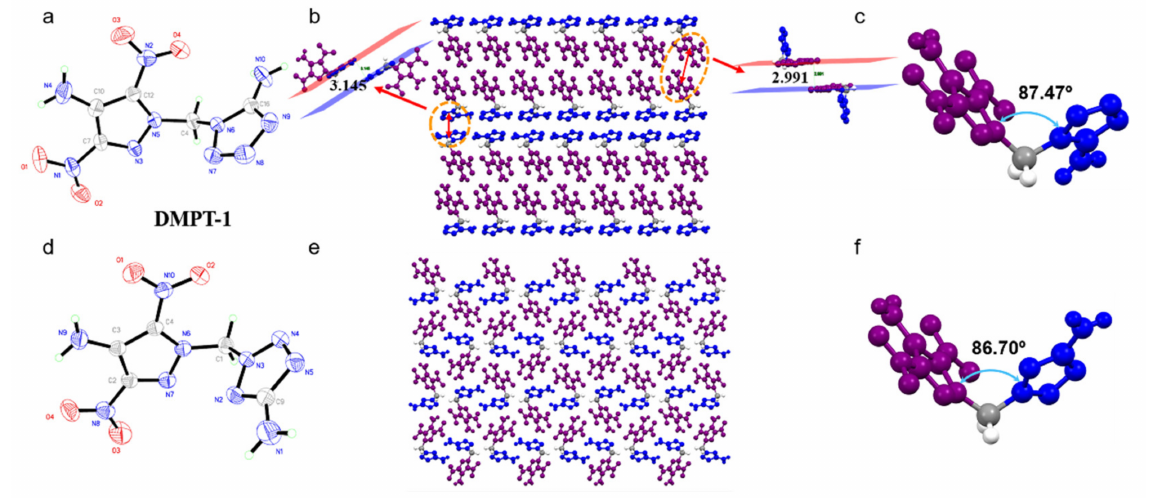
1.442(3) Å, and C1-N3, 1.455(3) Å. Crystal packing of DMPT-2 exhibits a mixing